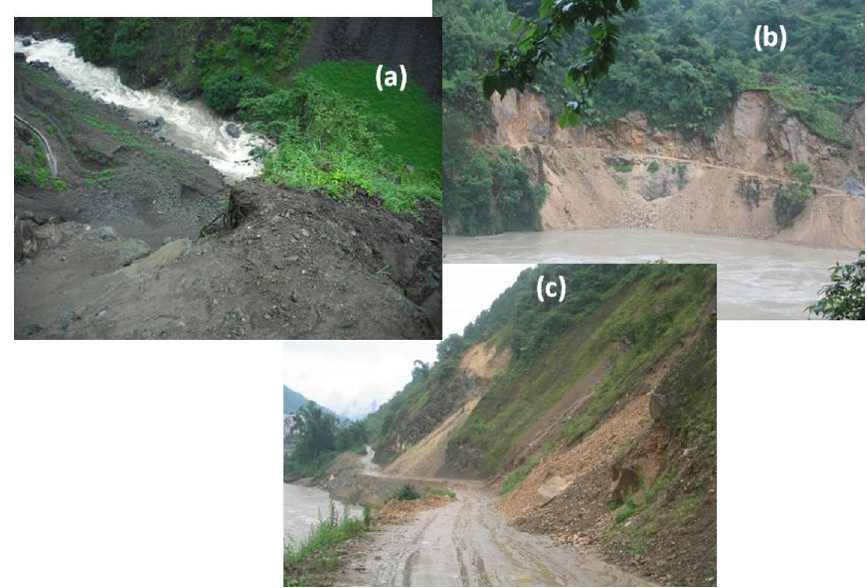
Figure 4. High rates of landslide sediment delivery to the Salween River from the (a) WTW and (b) FG1 roads.